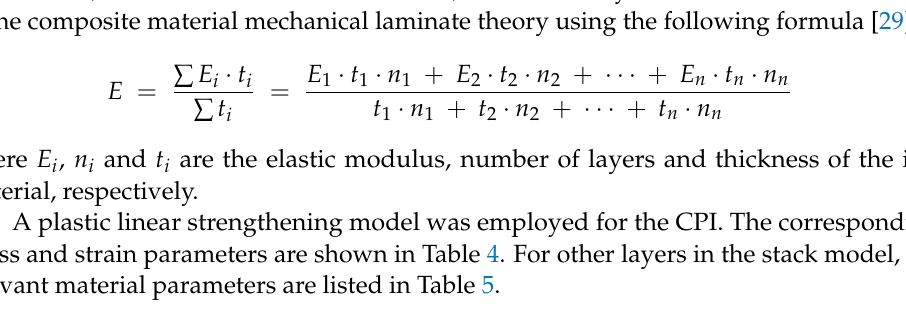
Table 4. Plasticity parameters.